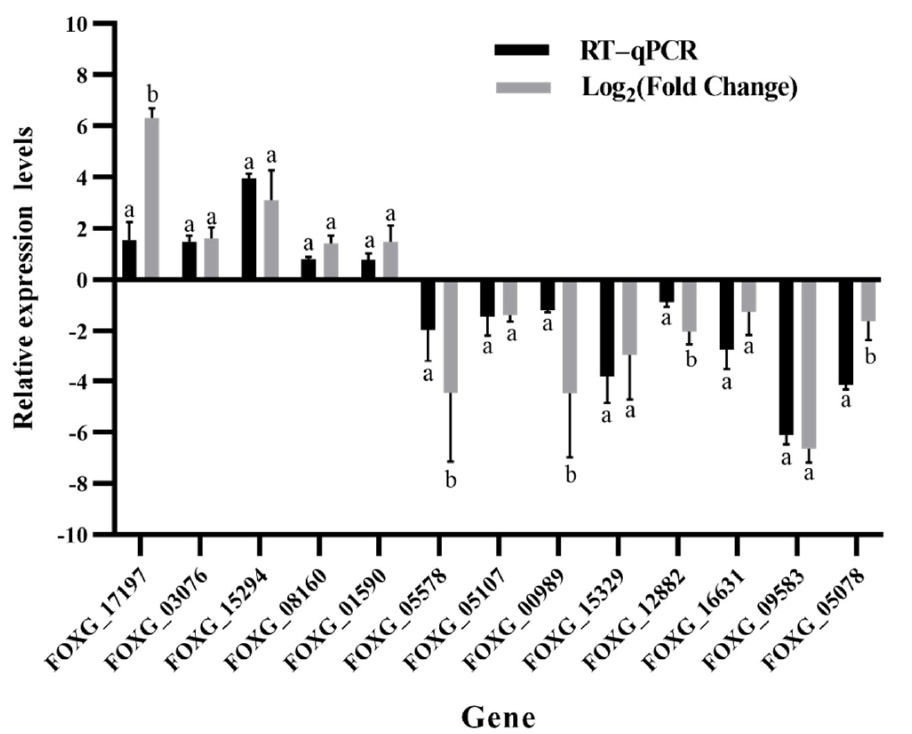
Figure 7. Relative expression level of 13 DEGs using the reference gene actin for normalization. Different lowercase letters in the table show significant differences via Duncan’s new complex polarization test ( p < 0.05